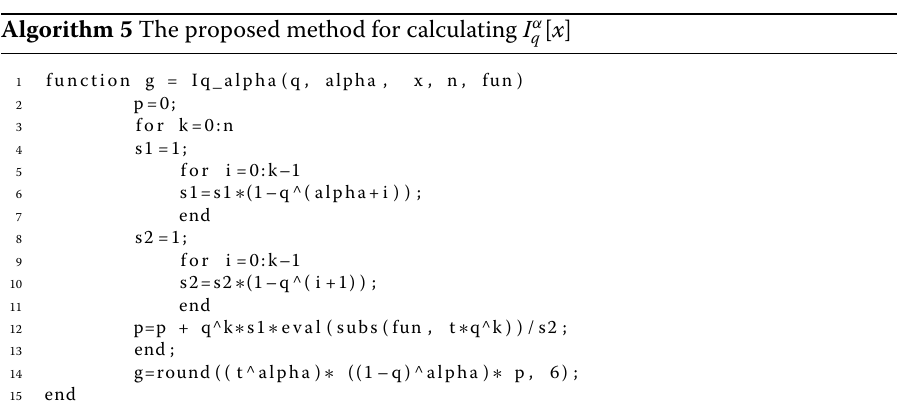
Algorithm 5 The proposed method for calculating I α